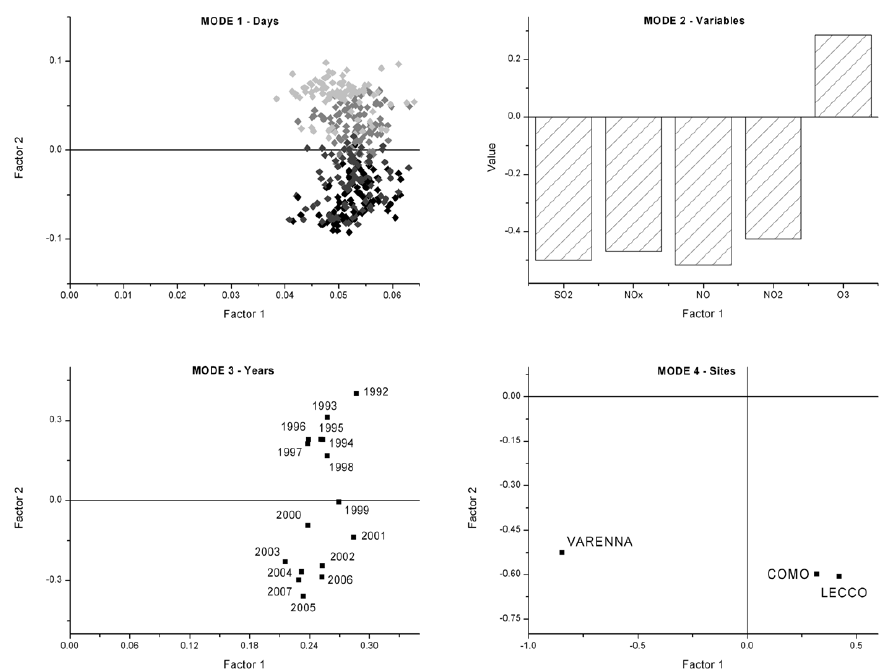
Figure 7. Four-way Tucker3 model of complexity [2,1,2,2]. MODE 1 (A) projection of the investigated days on the plane defined by Factor 1 (A1) and Factor 2 (A2); colors indicate the season, from black indicating the winter days to light grey labeling summer days; MODE 2 (B) projection of the analytes on the plane defined by Factor 1 (B1); MODE 3 (C) projection of the investigated years on the plane defined by Factor 1 (C1) and Factor 2 (C2); MODE 4 (D) projection of the sampling sites on the plane defined by Factor 1 (D1) and Factor 2 (D2).